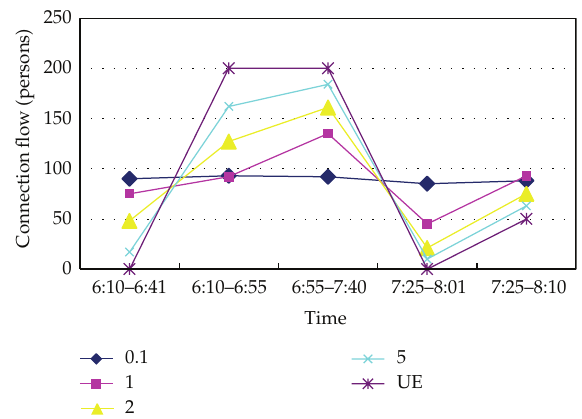
Figure 5: Passenger behaviour in choosing the departure time and the connection for various θ